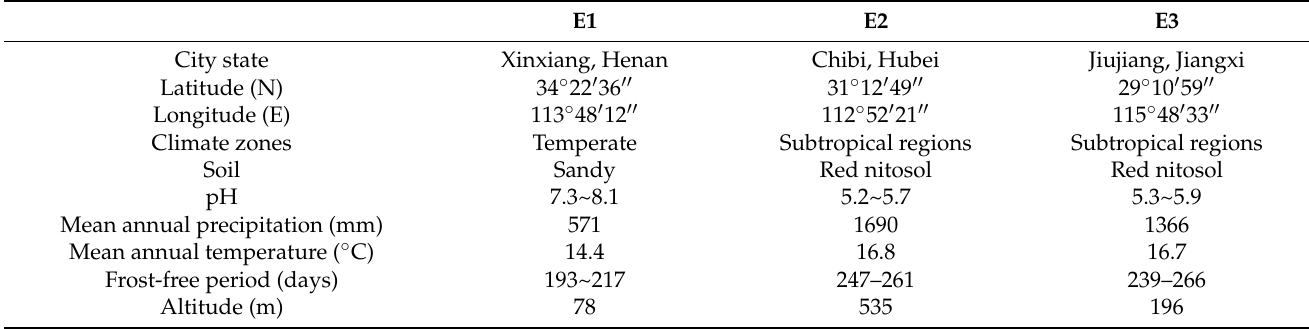
Figure 1. At each site, 1-year-old clonally propagated buried root seedlings with a root- collar diameter of 4.23 ± 0.5 cm were planted in the spring of 2013 in a randomized complete block design with 4 blocks, each of which contained 20 randomly distributed plots containing 6–8 seedlings of a given clone. Seedlings were planted at 4 m × 5 m spacing, and similar planting and maintenance procedures were used at each test site. Table 2. Geographical locations and environmental conditions at the three